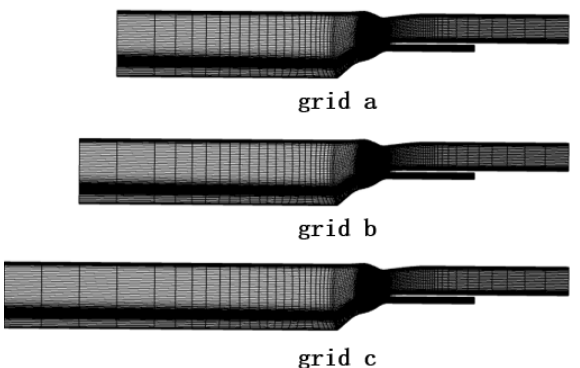
Figure 2. Computational mesh for the